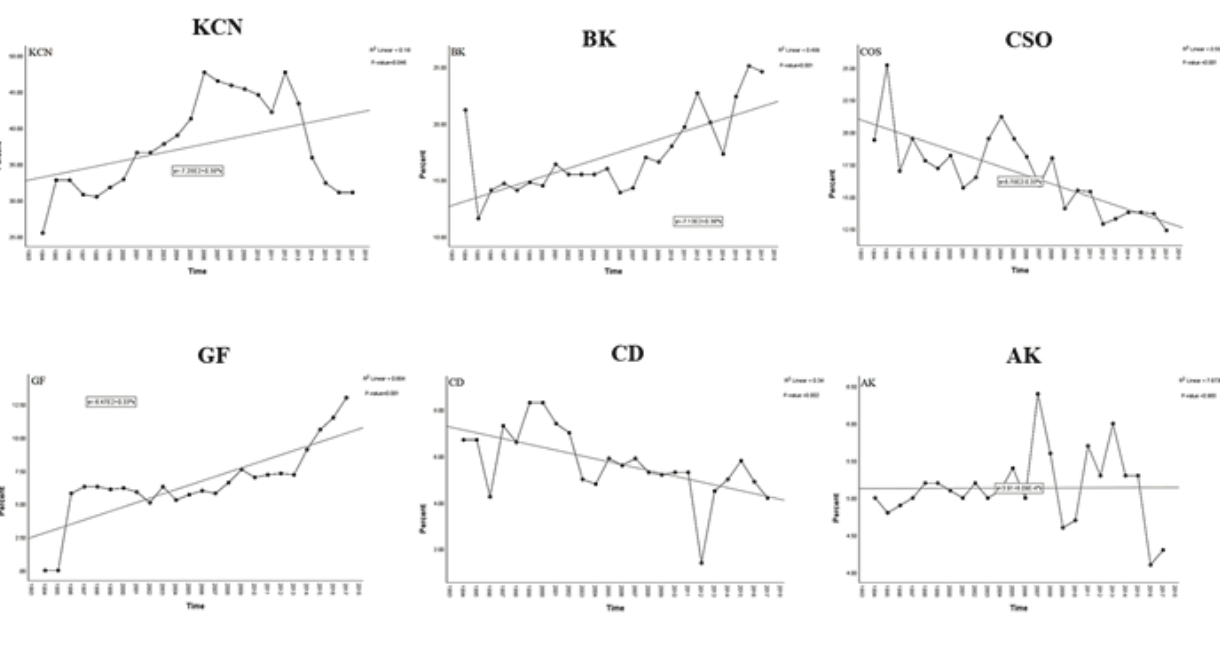
Figure 7. Trends of the leading indications for keratoplasty in Iran over the last 24 years. The trend of change for the rates of bullous keratopathy ( P < 0.001), graft failure ( P < 0.001), and keratoconus ( P = 0.046) shows a significant increase. A significant decreasing trend is observed for the rates of corneal scar and opacities ( P < 0.001) and corneal dystrophies ( P = 0.002). No significant change of trend is noted for active keratitis ( P = 0.968). The regression R 2 measures the goodness of fit of the regression line. AK, active keratitis; BK, bullous keratopathy; CD, corneal dystrophies; CSO, corneal scar and opacities; GF, graft failure; KCN,